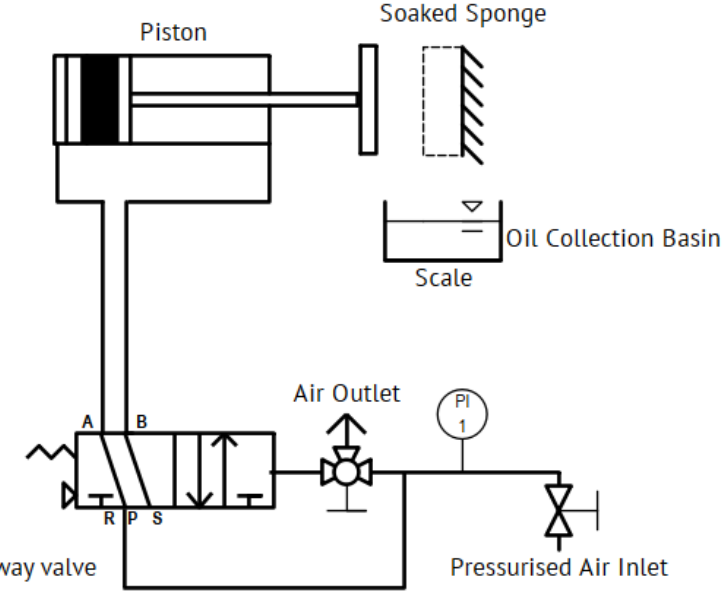
Figure 2. Scheme of the experimental setup for mechanical removal of oil from the sponge. A 5/2-way valve and a one-way restrictor are used to fill and empty the pressure chambers of the double-acting piston cylinder with pressurised air from the air